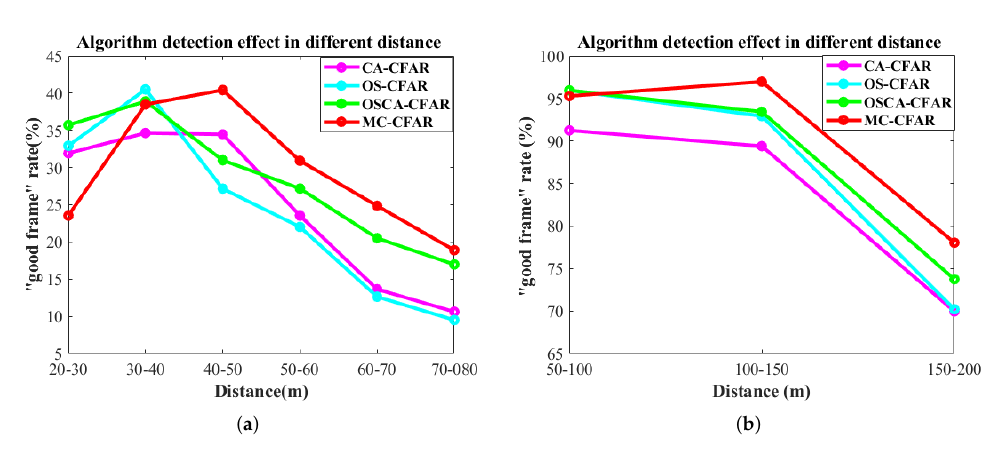
Figure 19. Algorithm testing at different distances. ( a ) Pedestrian detection results. ( b ) Vehicle detection